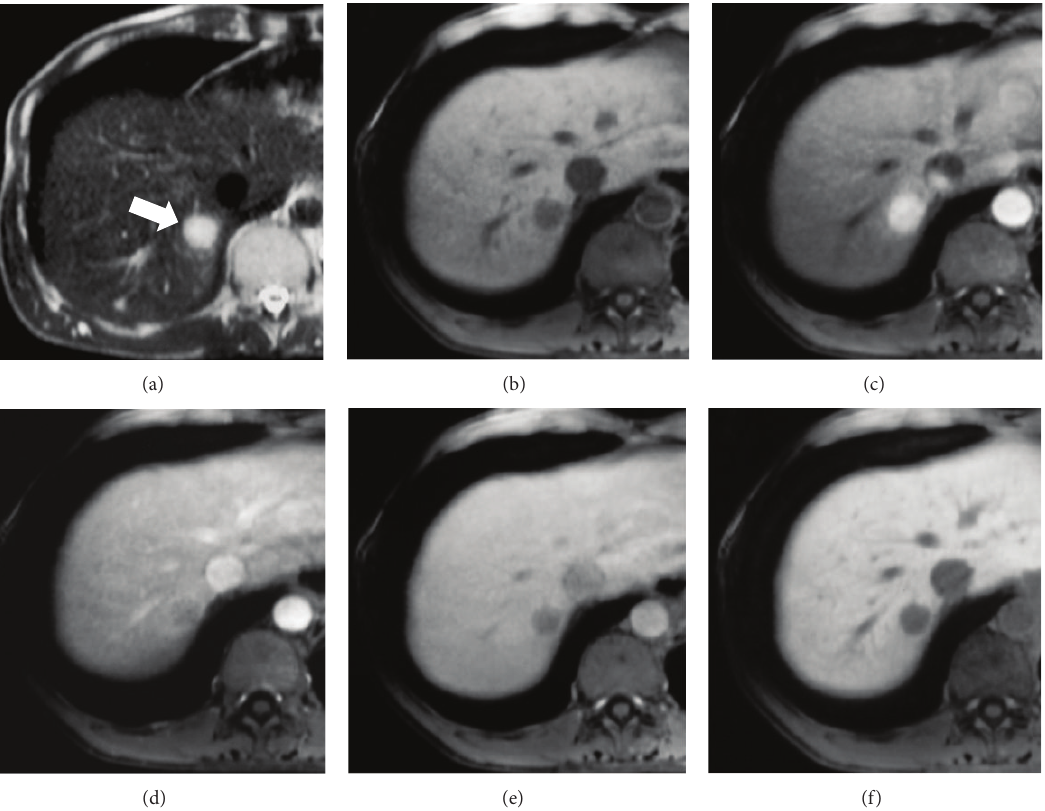
Figure 13: Neuroendocrine hepatic metastasis. (a) On T2w image well-defined homogeneous markedly hyperintense nodule (arrow) in S VII. (b–e) On precontrast T1w fat sat images the lesion is hypointense (b). On contrast enhanced MRI the nodule shows homogeneous evident enhancement in arterial phase (c) with rapid wash out in portal phase, more evident in equilibrium phase. (f) In epatobiliary phase, 10’ after GD-EOB-DTPA, the nodule is